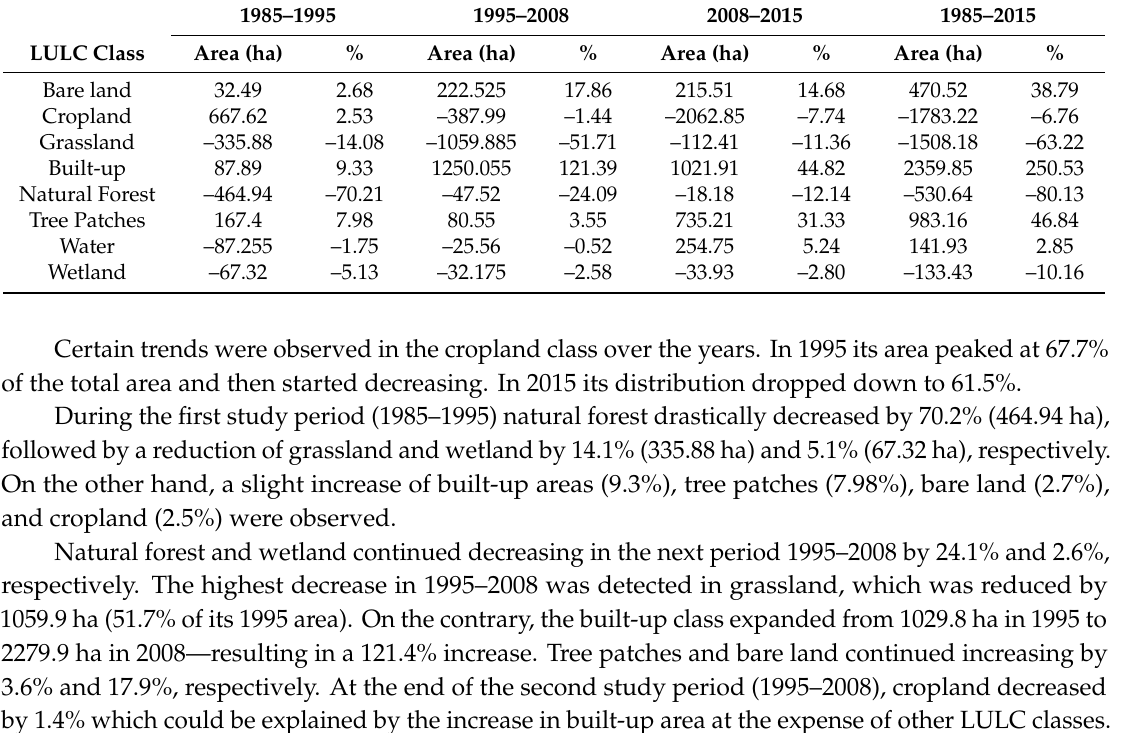
Table 6. Results of LULC changes between di ff erent periods in hectare (ha) and percentage in percentage (%). LULC Changes between